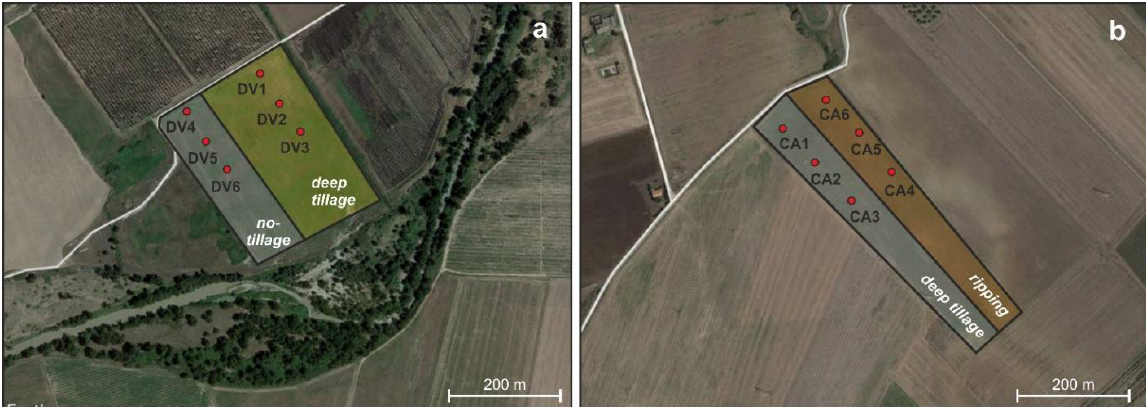
Figure 3. Distribution of sampling points (red points) within each area managed with different agronomic techniques. ( a ) DV study site with deep tillage (DT) and no tillage as conservative agronomic practices (CP). ( b ) CA study site with deep tillage (DT) and ripping technique as conservative practices (CP) (background image from Google